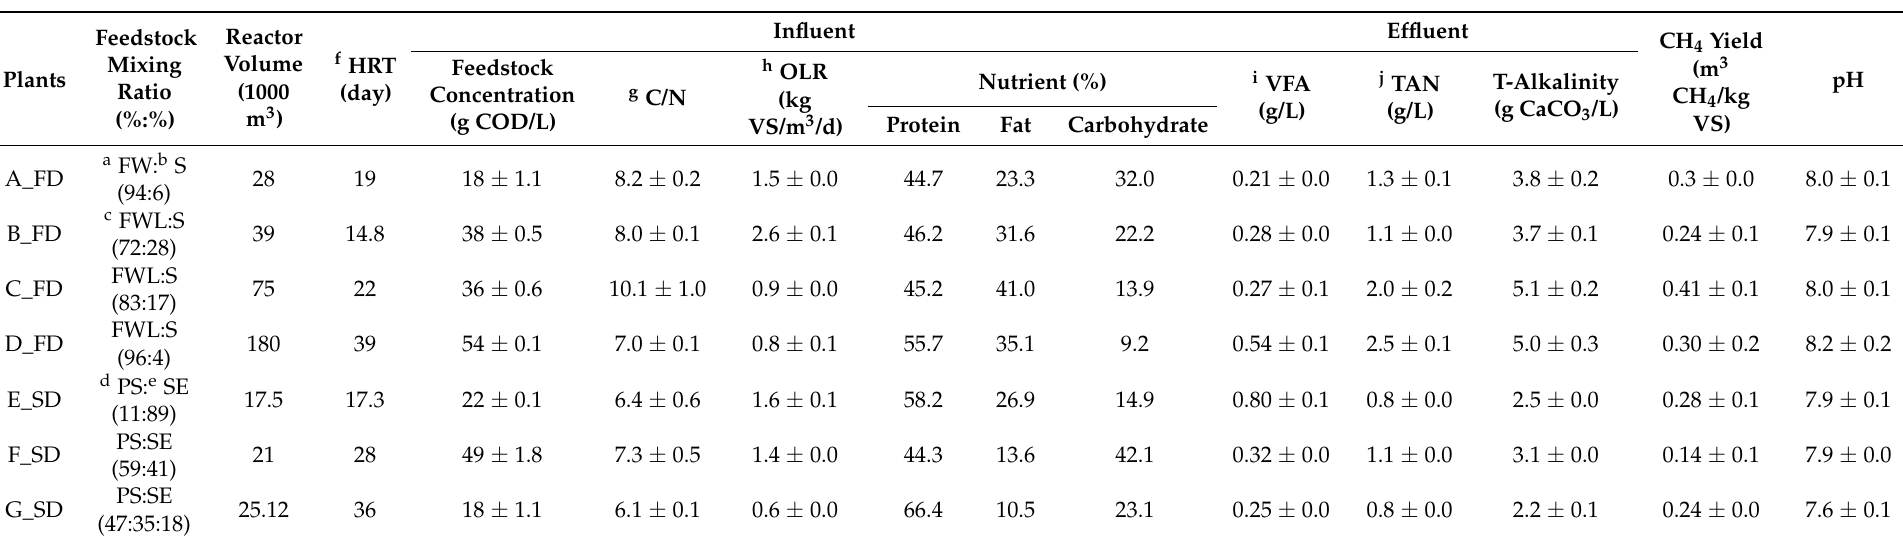
Table 1. Characteristics and operational parameters of seven full-scale anaerobic digestion plants treating food waste and sewage